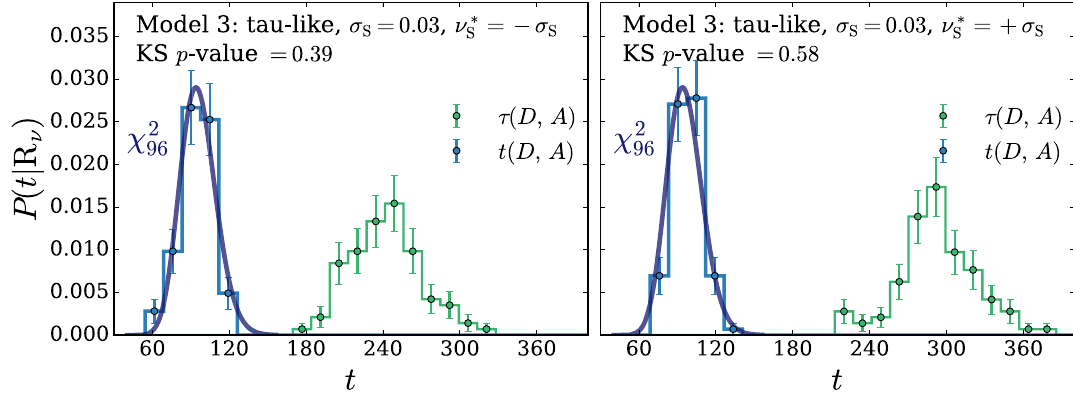
Fig. 20 Same as Fig. 19, but after enriching the reference sample in the region of high transverse momentum with 200 (cid:16) 000 additional events